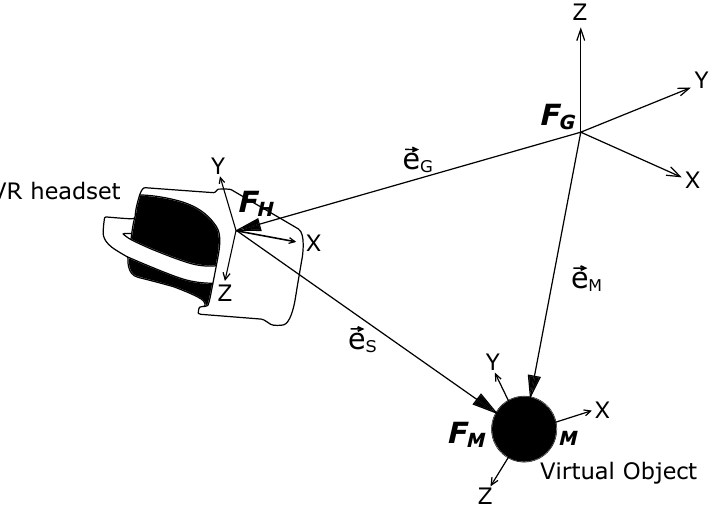
Figure 4. Vector Representation of the Virtual Object and the VR